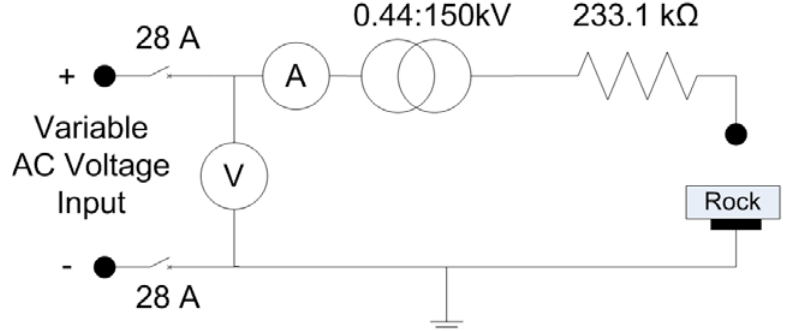
Figure 1. Circuit diagram for high voltage electrical arc discharge experiments. The 60 Hz AC voltage source magnitude was increased until an arc formed. This tripped the circuit breakers, which trip at 28 A (referred to the portion of the circuit show). The 0.44:150 kV transformer was assumed to be ideal. Measurements were taken on the primary side of the transformer.